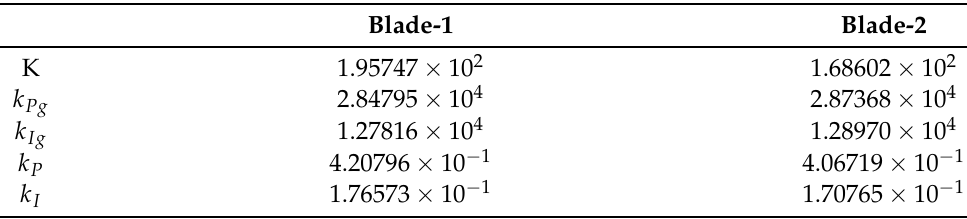
Table 4. Controller constants for three regions computed in